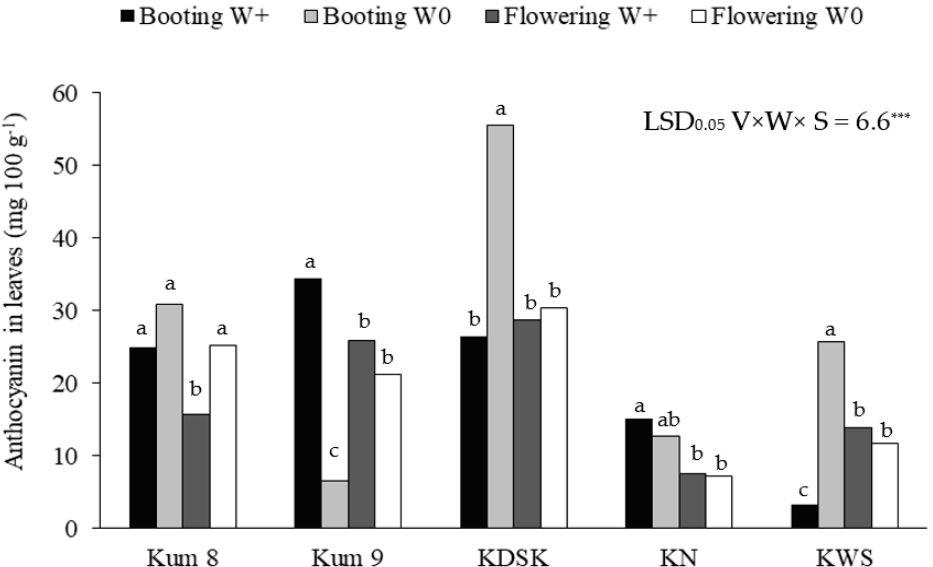
Figure 2. Anthocyanin concentrations in leaves at booting and flowering stages of 5 purple rice varieties grown under waterlogged (W+) and aerobic (W0) conditions (Significant interaction effect of variety × water regime × growth). Significant interaction effect of variety × water regime × growth stage at p < 0.001 ***. Different lowercase letters above the bars indicate least significant differences between treatment means in each variety at p < 0.05.